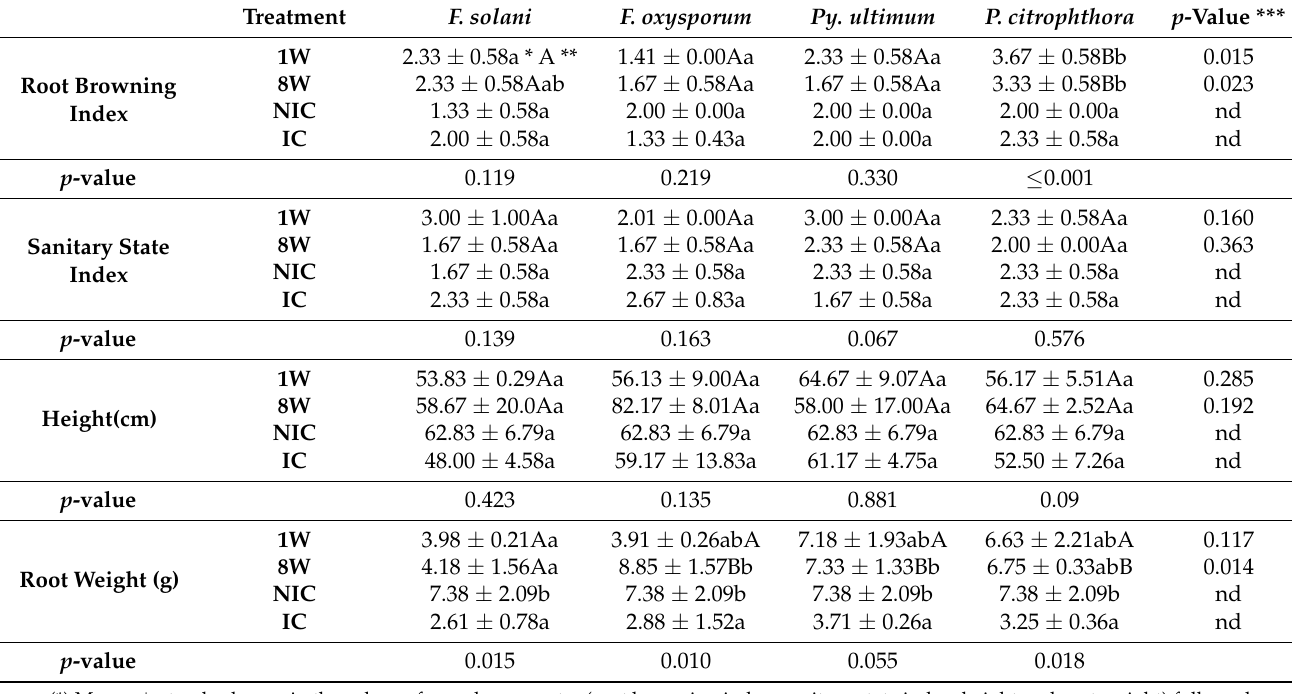
Table 2. Effect of Raphanus raphanistrum fine powder on the severity of decline disease and seedlings growth three months after the inoculation on peach seedlings